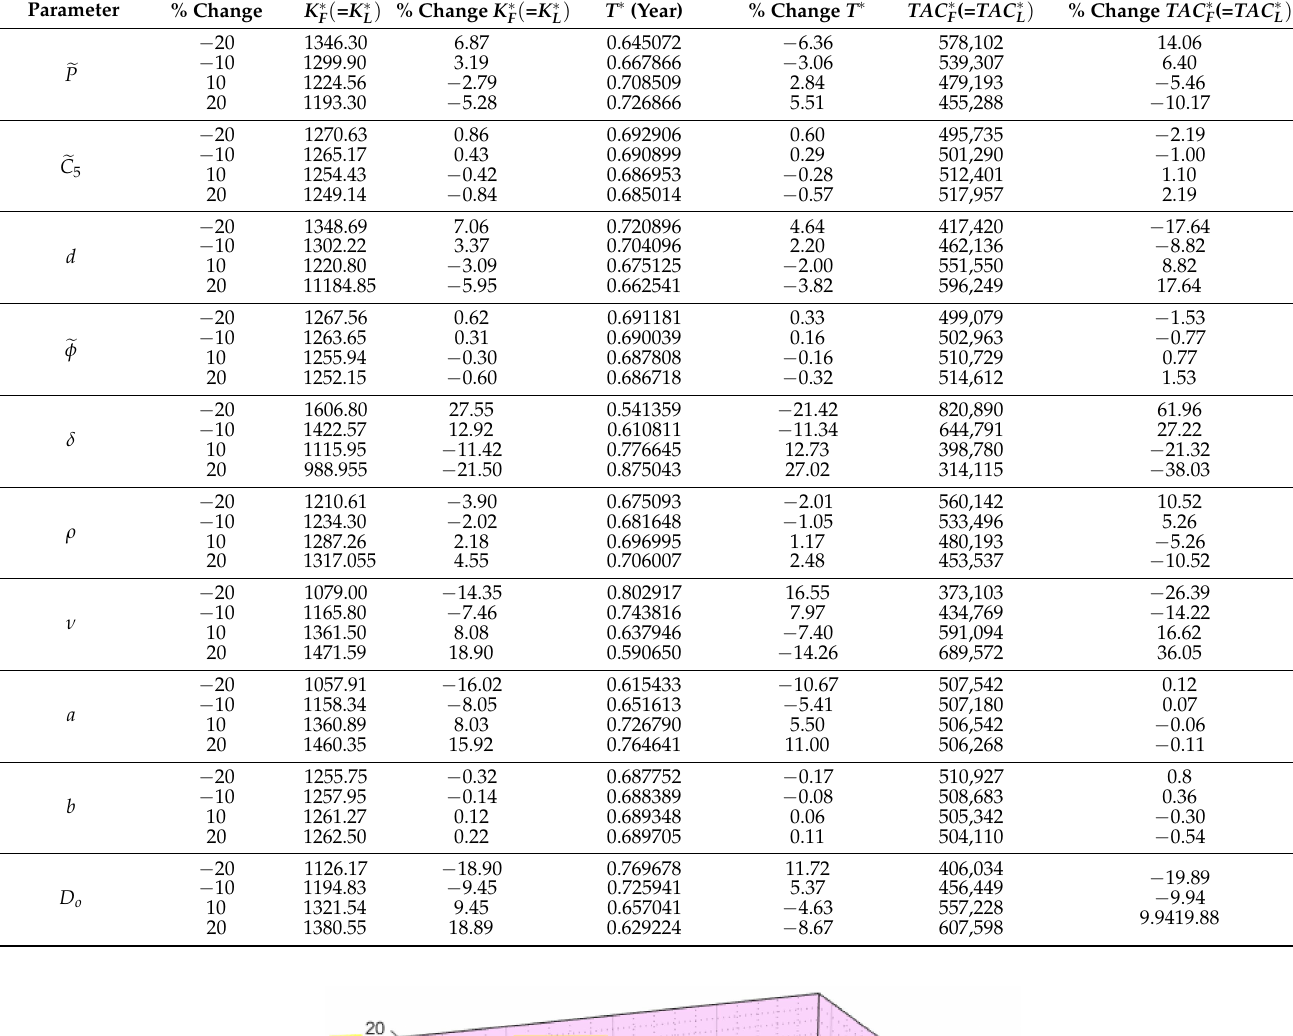
Table 9. Sensitivity analysis of the total inventory cost under the same holding and deterioration costs of both OW and RW.